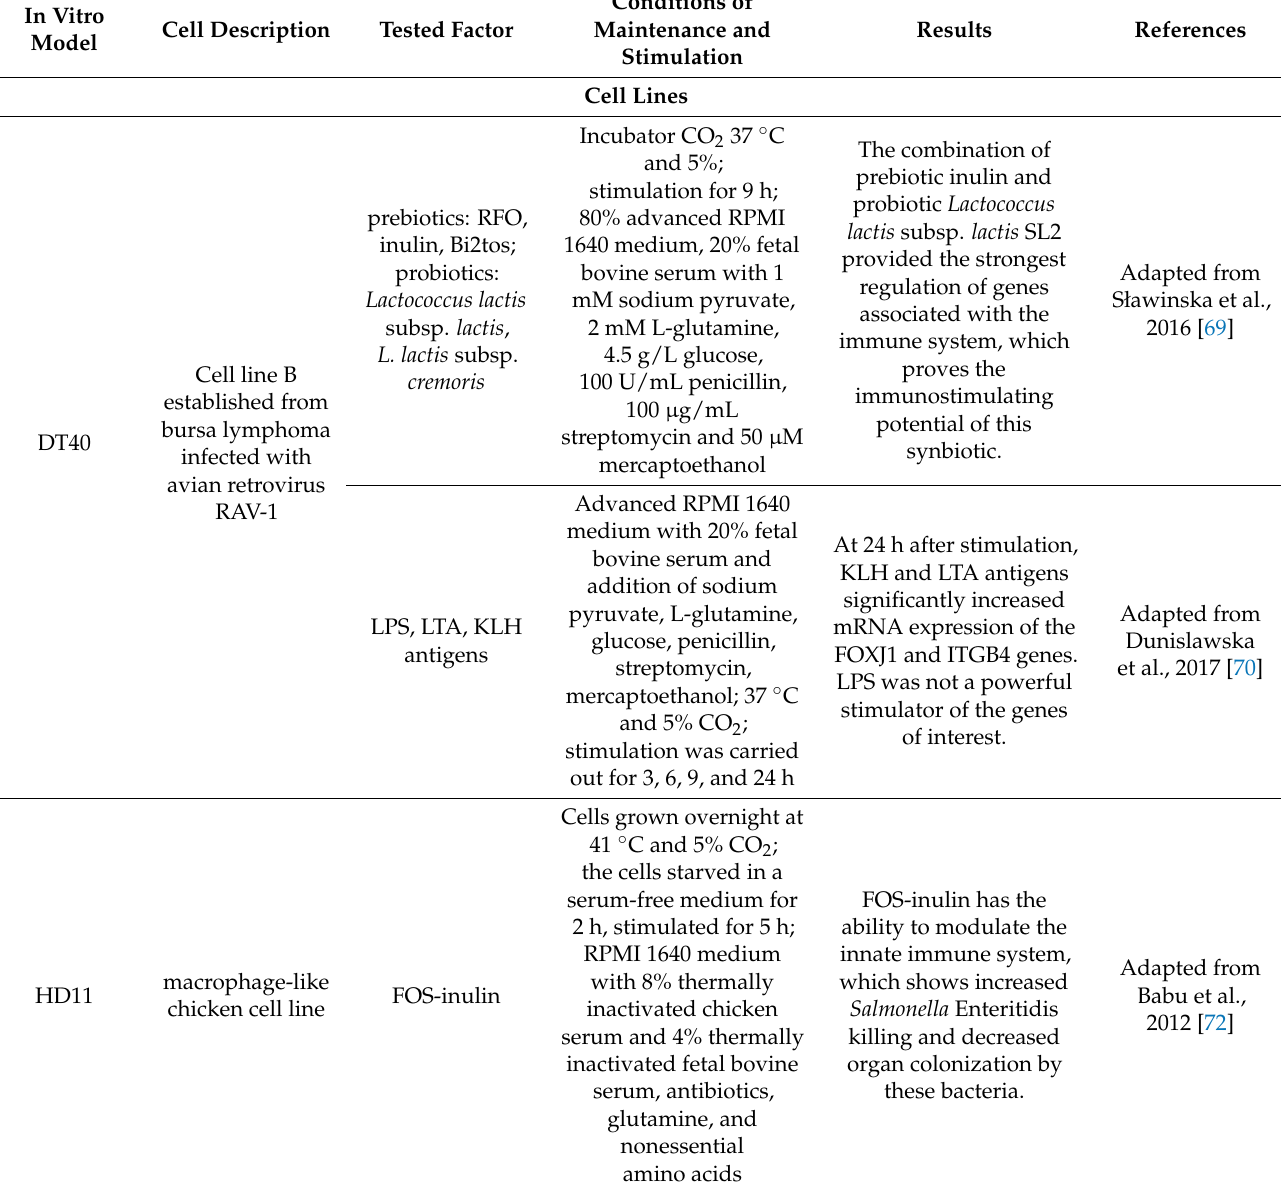
Table 3. Overview of immune-related avian cell lines and culturing